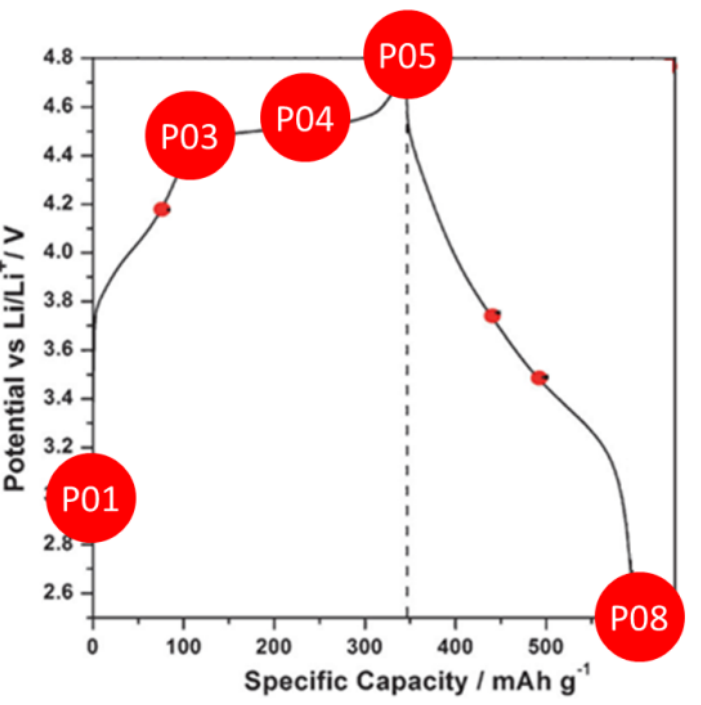
Figure 1. Labeling of the set of samples used in this study, represented as charge points in the corresponding galvanostatic charge-discharge cycle. Each point corresponds to an uncoated sample (e.g., P01) and a VOx-coated one (e.g., P01VC).